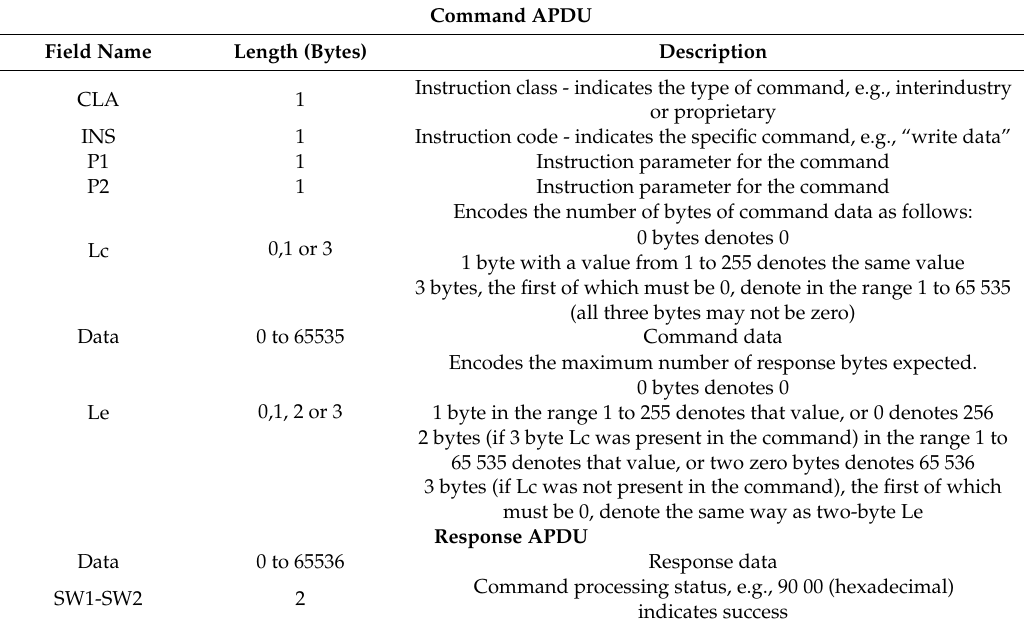
Table 7. Application Data Protocol definitions for invoking Daedalus security API.